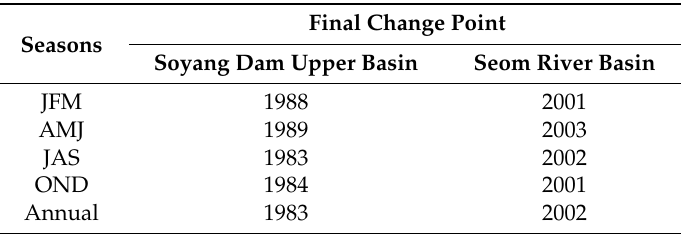
Table 5. Results of final change point in two